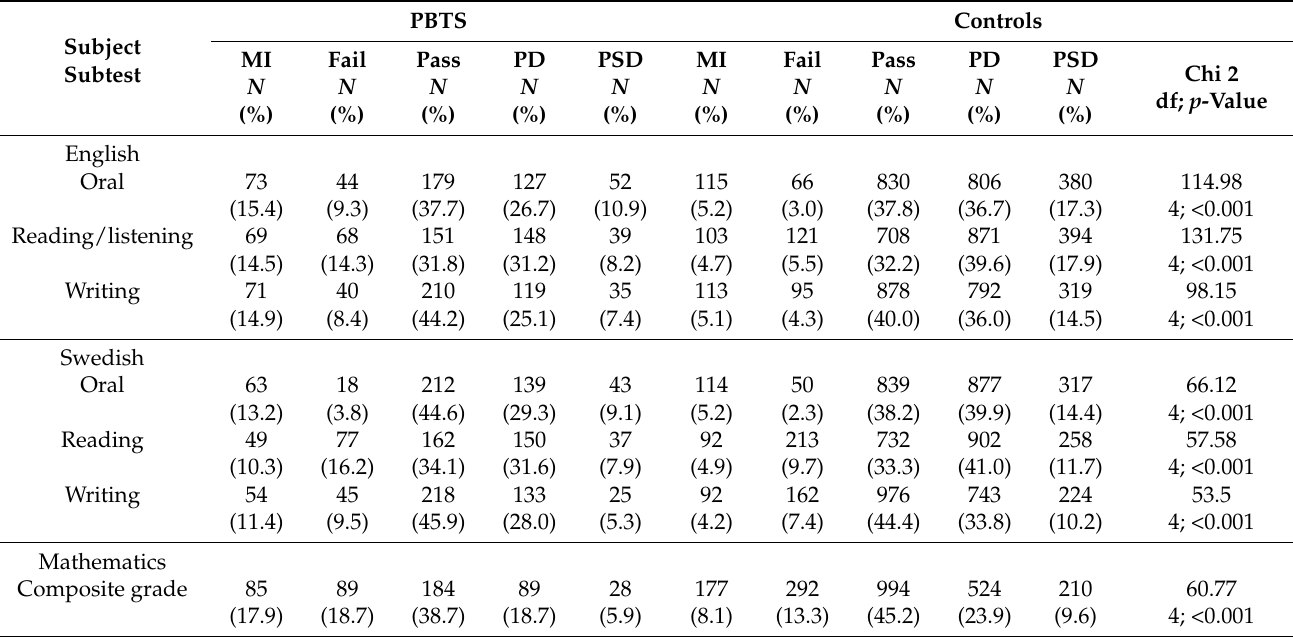
Table 3. Observed numbers and percentages for PBTS and controls regarding missing information (MI), fail, pass, pass with distinction (PD) and pass with special distinction (PSD) in the national tests of English, Swedish and mathematics school year 9. Chi-square comparisons between PBTS ( n = 475) and controls ( n = 2197) for each subtest in English and Swedish and for the composite grade in mathematics. df: degrees of freedom.